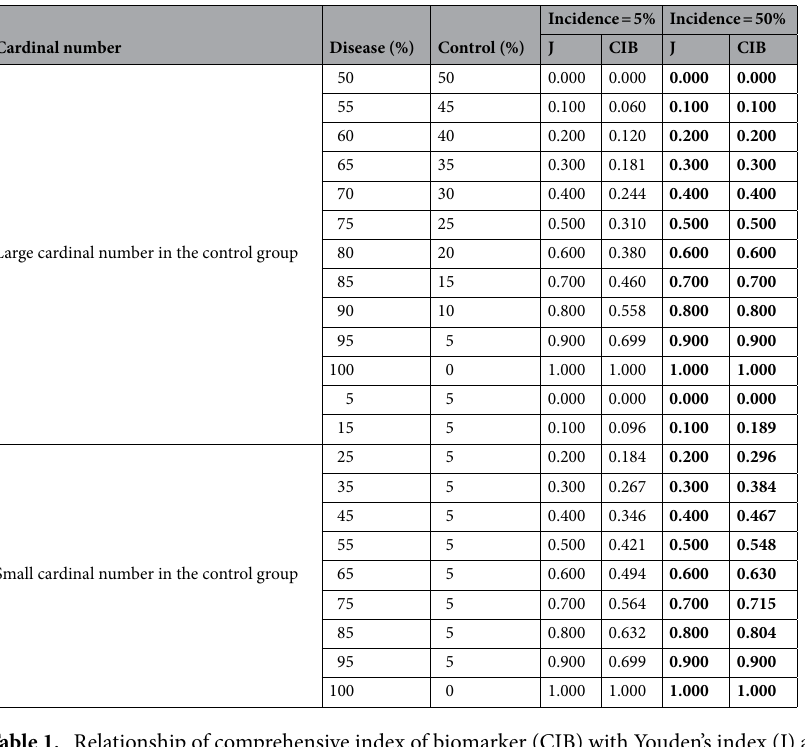
Table 1. Relationship of comprehensive index of biomarker (CIB) with Youden’s index (J) according to incidence in the total population. Boldface: Numerical value is similar. Cardinal number: frequency in the control group.